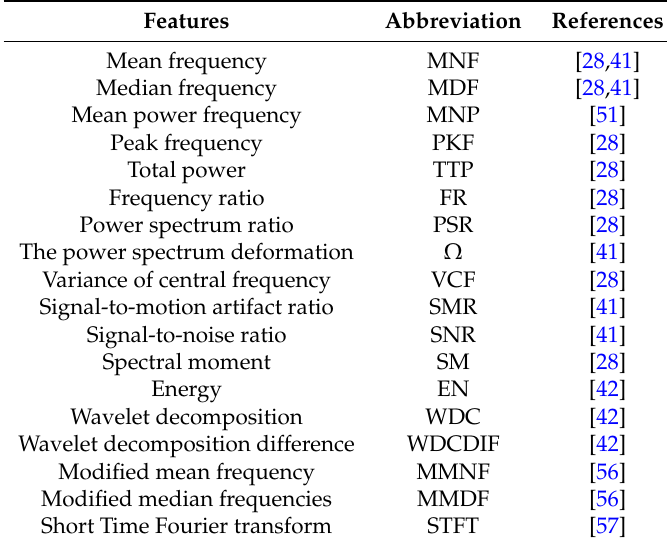
Table 2. Frequency domain